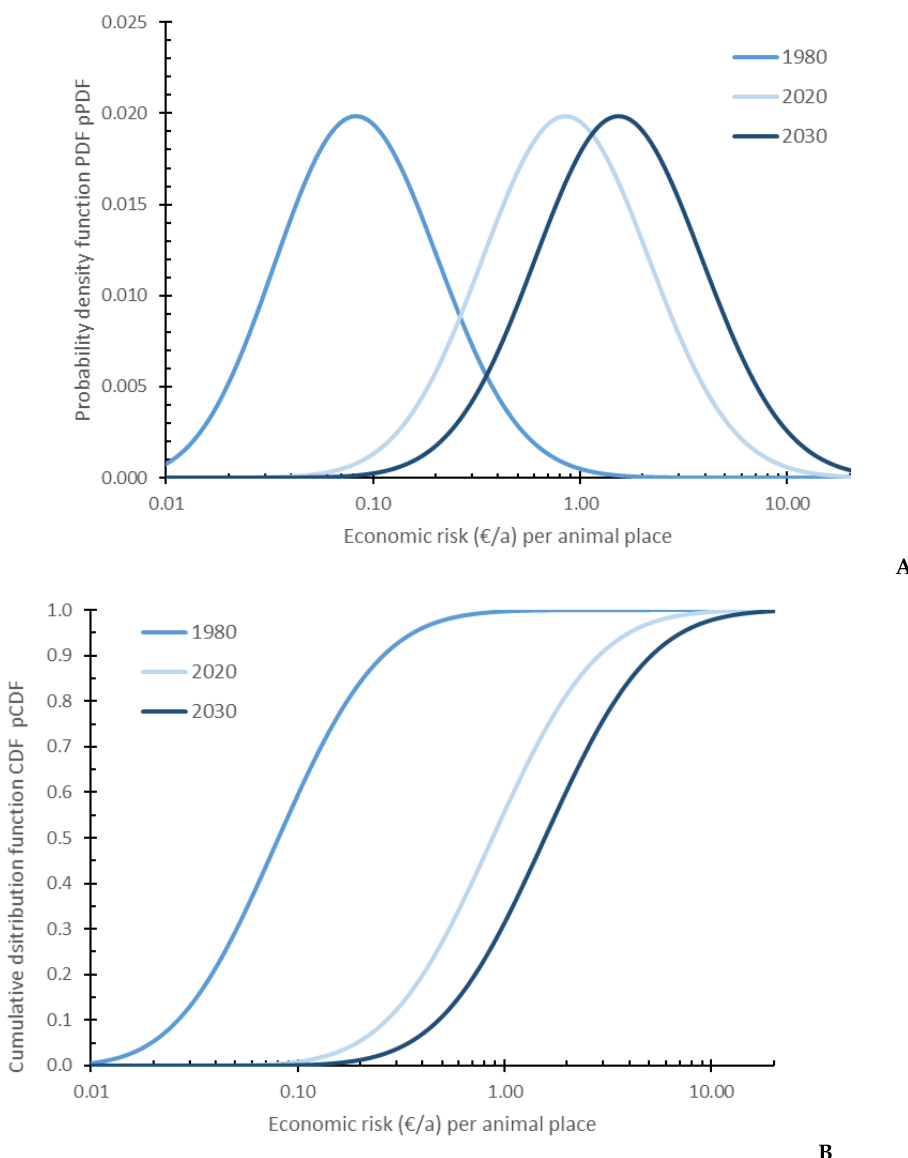
Figure 7. Distribution of the economic risk (€/a) per animal place by the reduction of the gross margin for t = 1980, t = 2020 and t = 2030 shown by probability density functions (PDFs panel A ) and cumulative distribution functions (CDFs panel B